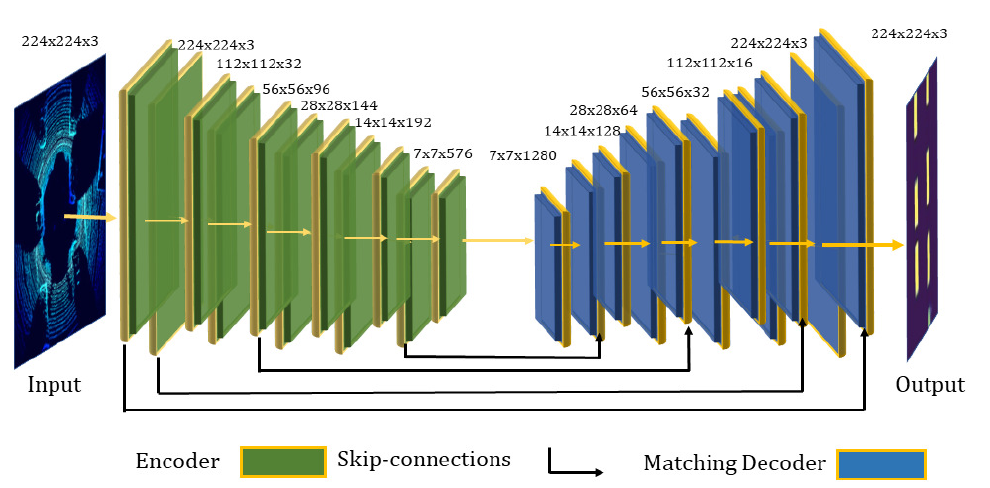
Figure 4. Schematic illustration of an encoder-decoder architecture. The left-hand side is a birds- eye-view RGB map that is passed to a series of computational layers, and the right-hand side is the output decoder feature map. The arrows are skip connection layers, where input is being directly concatenated from encoder to